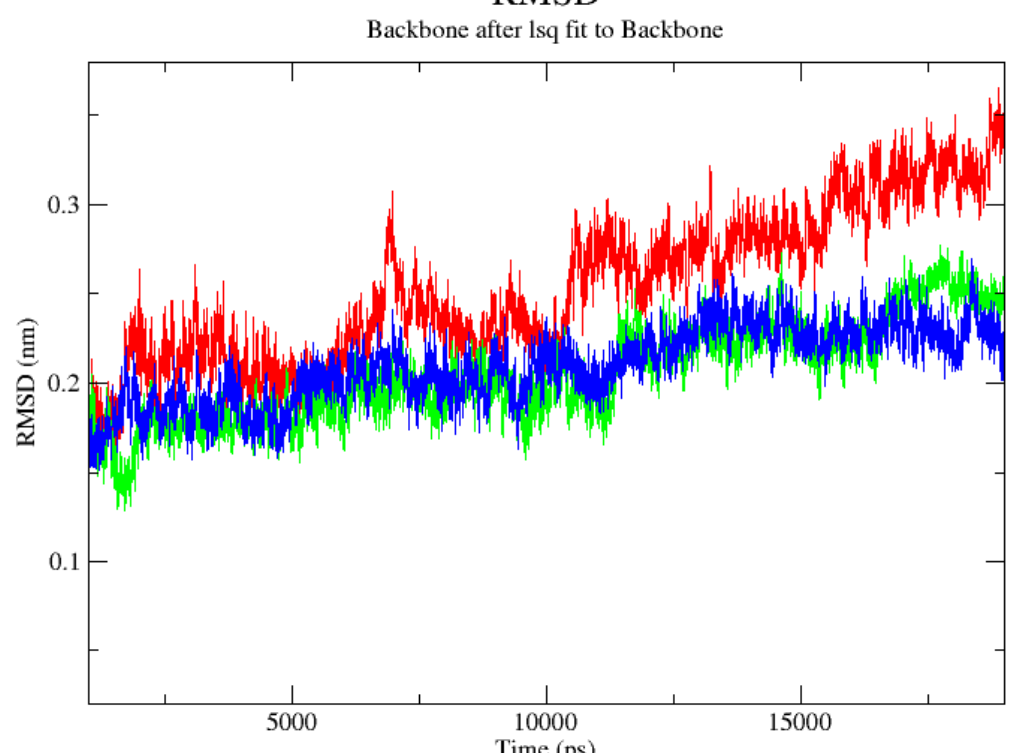
Figure 2. The RMSD plot for the ligand within ligand–protein complex during the MD productive phase was calculated for the complex of OA (red), HIMOXOL (green), or Br-HIMOLID (blue) and the 3pp0.pdb cavity.